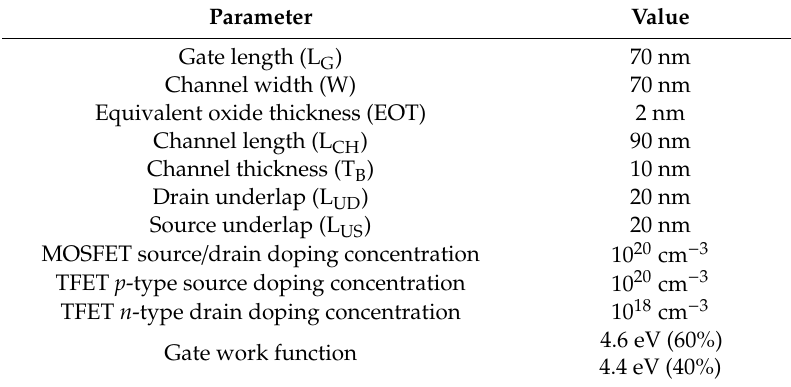
Figure 1. Basic schematics and major parameter definitions of the ( a ) metal-oxide-semiconductor field-effect transistor (MOSFET), ( b ) planar tunnel field-effect transistor (TFET), ( c ) double-gate (DG) TFET, and ( d ) electron-hole bilayer TFET (EHBTFET) used in this research. Table 1. Device parameters of devices used for the technology computer-aided design (TCAD) simulation.